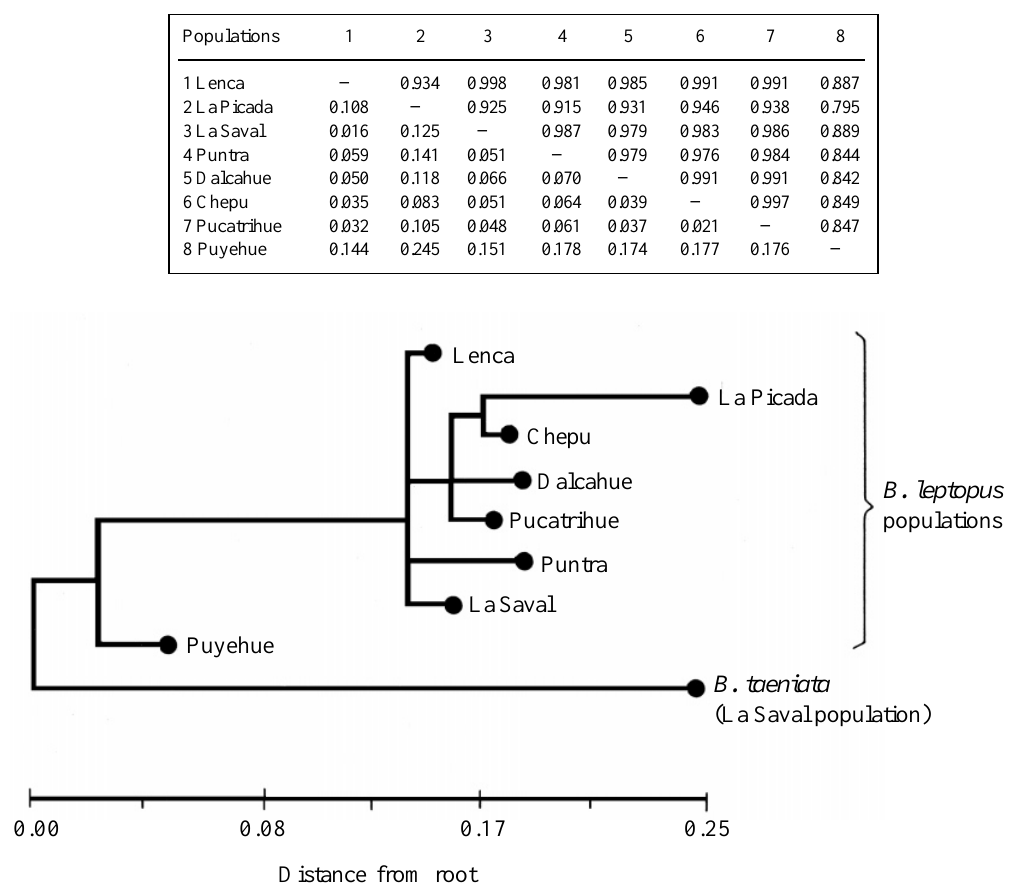
Figure 2 - Wagner tree showing the allozymic relationships among Batrachyla leptopus populations. The tree was rooted using the outgroup method. Cophenetic correlation =